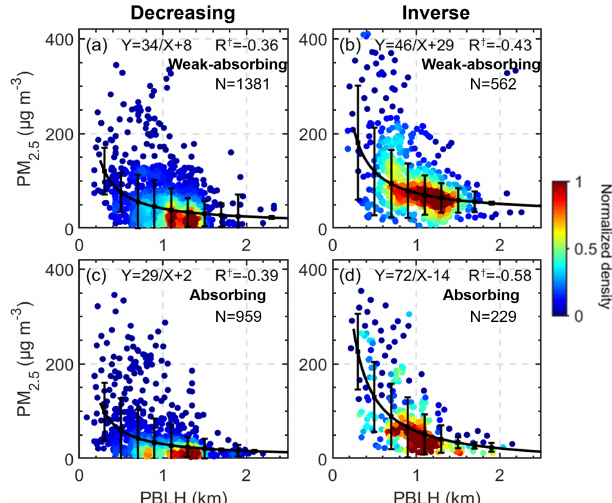
Figure 5. The relationship between MPL-derived PBLH and PM 2 . 5 for (a) weakly absorbing and (c) absorbing aerosols for the decreas- ing aerosol structure. The relationship between MPL-derived PBLH and PM 2 . 5 for (b) weakly absorbing and (d) absorbing aerosols for the increasing (i.e., inverse) aerosol structure. Black lines represent the inverse fits, and the whiskers indicate the standard deviations. The fitting functions and number of samples are given in each panel, along with the correlation coefficient ( R † ) for the inverse